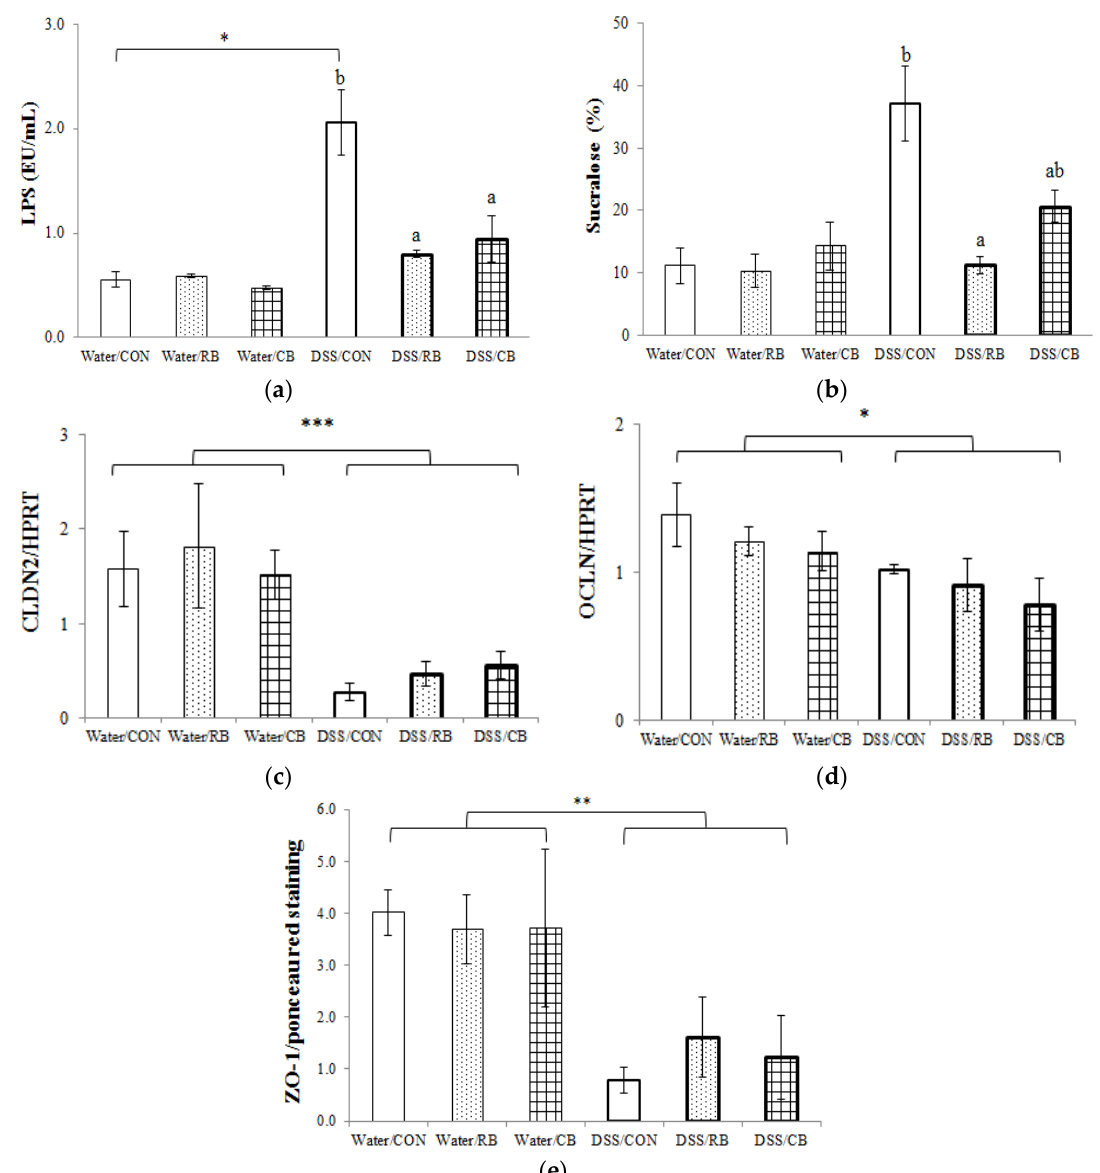
Figure 4. The effect of diet and dextran sulfate sodium (DSS) on gut barrier function: ( a ) plasma lipopolysaccharide (LPS) concentration, n = 3, except for DSS/RB ( n = 4); ( b ) urinary sucralose excretion, n = 3, except for DSS/CON and DSS/RB ( n = 2); ( c ) mRNA expression of CLDN2, normalized by HPRT, n = 3, except for DSS/RB ( n = 4); ( d ) mRNA expression of OCLN, normalized by HPRT, n = 3, except for DSS/RB ( n = 4); and ( e ) protein expression of ZO-1, n = 3, except for DSS/CB ( n = 2). Diet groups are tap water and control (Water/CON), tap water and 10% raw broccoli (Water/RB), tap water and 10% lightly cooked broccoli (Water/CB), DSS and control (DSS/CON), DSS and 10% raw broccoli (DSS/RB), and DSS and 10% lightly cooked broccoli (DSS/CB). Data are mean ± SE. * and *** indicate a significant effect of DSS ( p < 0.05 and p < 0.001, respectively). ** indicates p < 0.01; The presence of letters indicates a significant effect of diet within Water groups or DSS groups ( p < 0.05). Values with the same letter are not different ( p < 0.05).